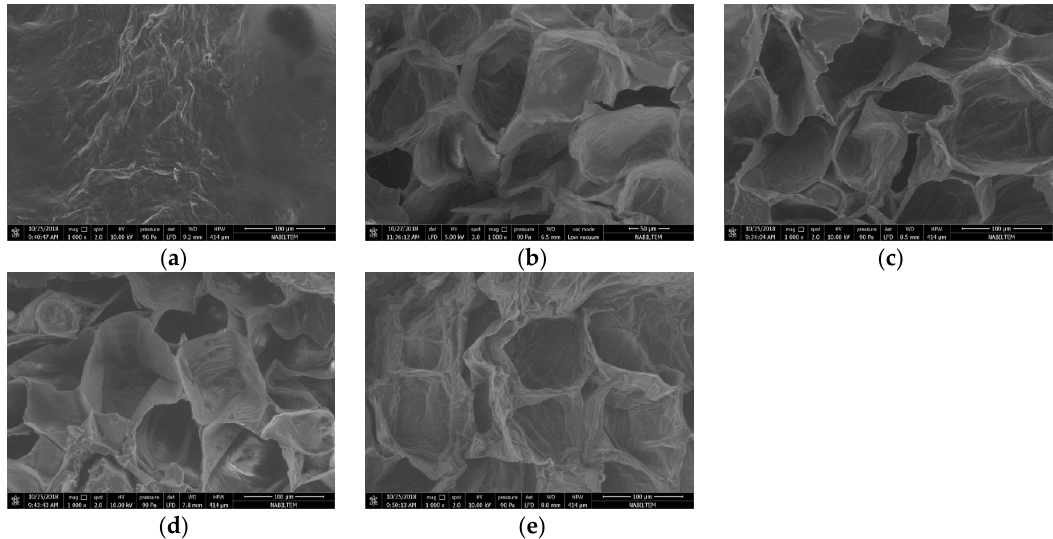
Figure 7. SEM (Scanning Electron Microscope) images of persimmon with 5 mm: ( a ) fresh persimmon; ( b ) dried persimmon at 120 W; ( c ) dried persimmon at 350 W; ( d ) dried persimmon at 460 W; ( e ) dried persimmon at 600 W.